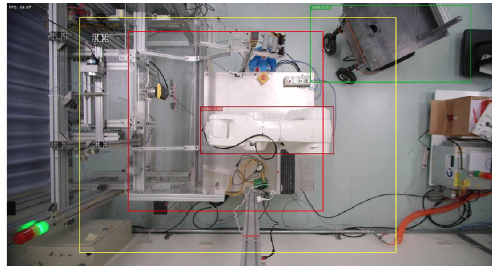
Figure 13. AMR enters first warning range.